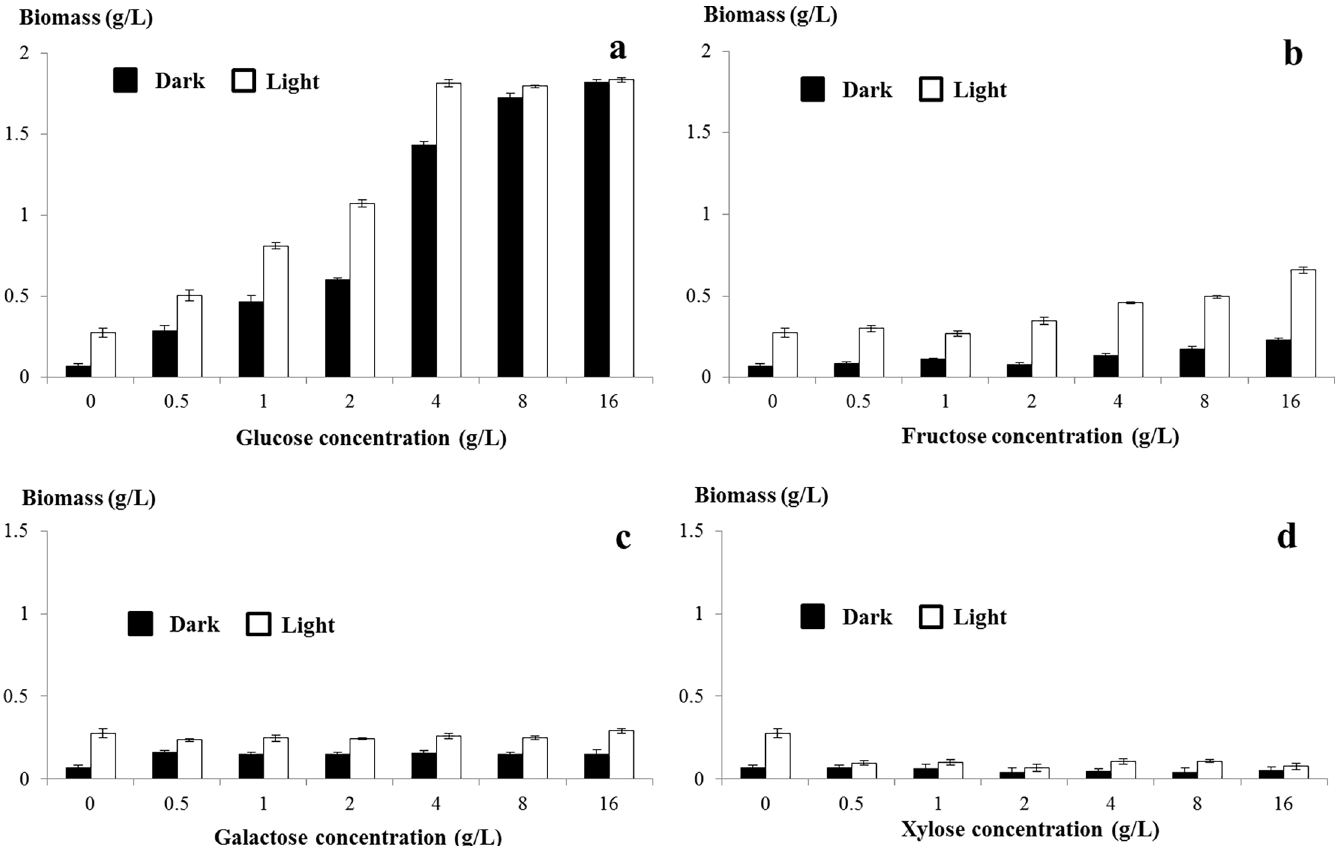
Fig 4. Biomass analysis of Chlorella sorokiniana UTEX 1230 in monosaccharide-supplemented medium. C . sorokiniana UTEX 1230 cells were collected after 7 days and dried to a constant weight at 80 ˚C to weigh biomass. X- and y-axes on the graph correspond to monosaccharide concentration and biomass (g/L), respectively. a, b, c and d show the biomass of cells cultivated in glucose-, fructose-, galactose- and xylose-supplemented media, respectively. Data shown as mean +/-SD, n = 3. Black bar: dark conditions; white bar: light conditions.